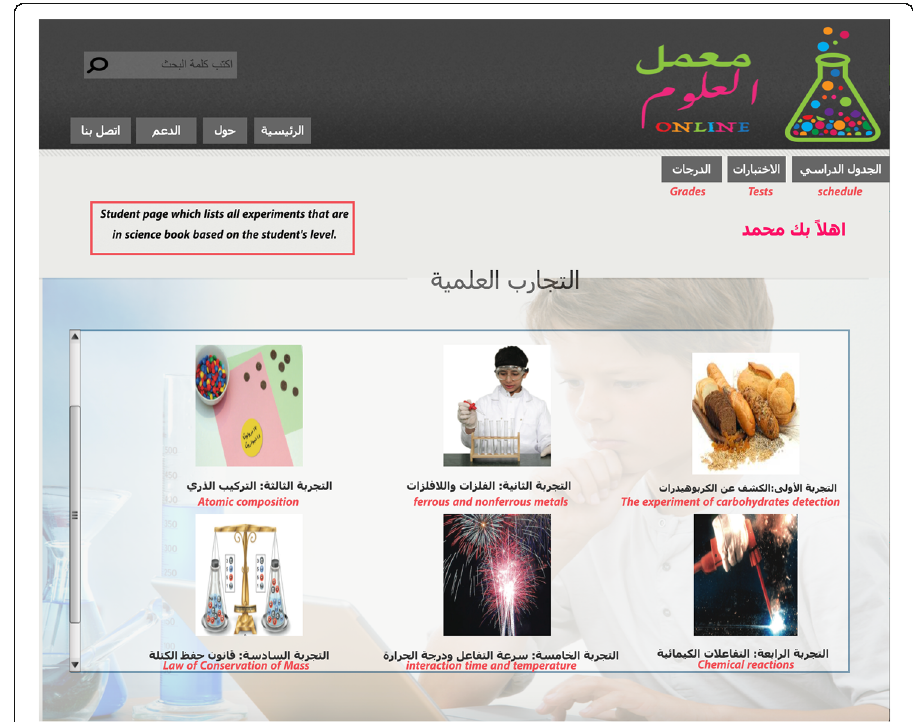
Fig. 4 Screenshot of the student screen on the VSL